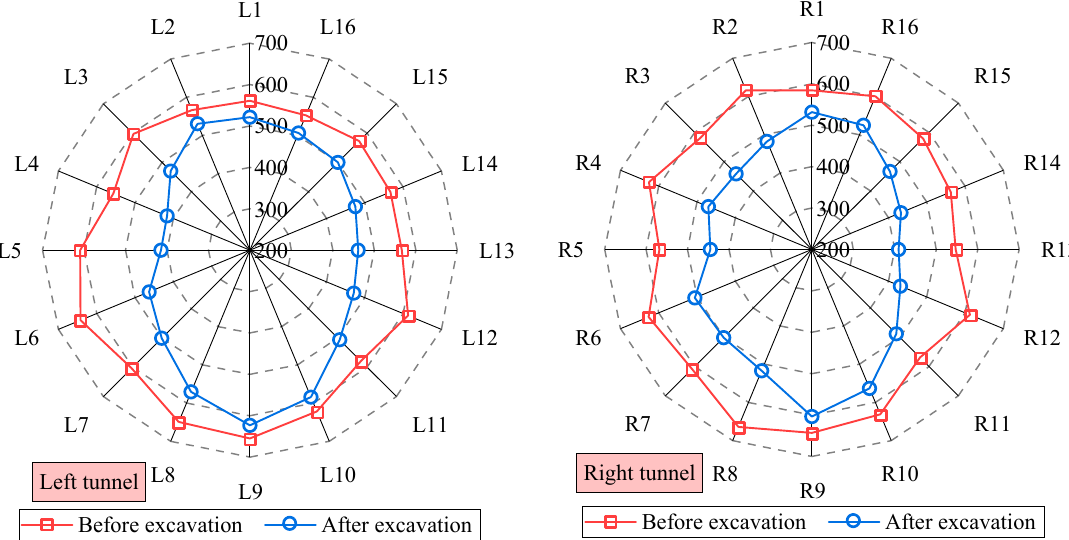
Figure 12. Variation of tunnel axial force before and after excavation (unit: kN).